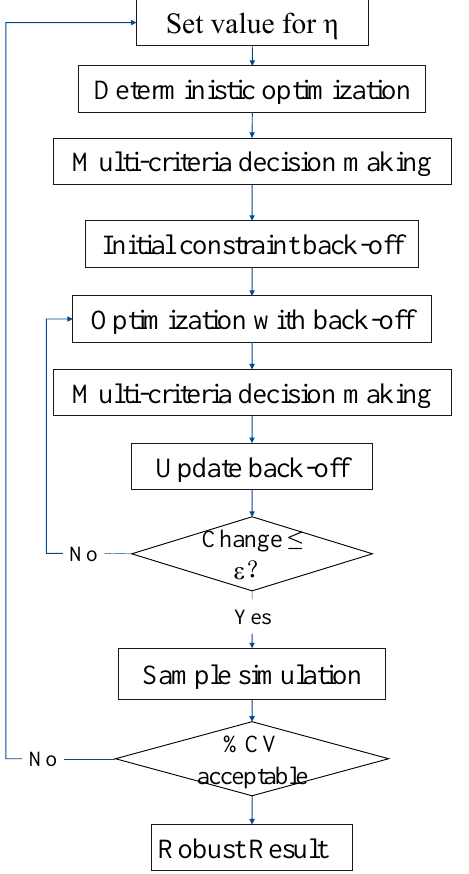
Figure 2. Schematic diagram of the proposed robust multi-objective optimization method.